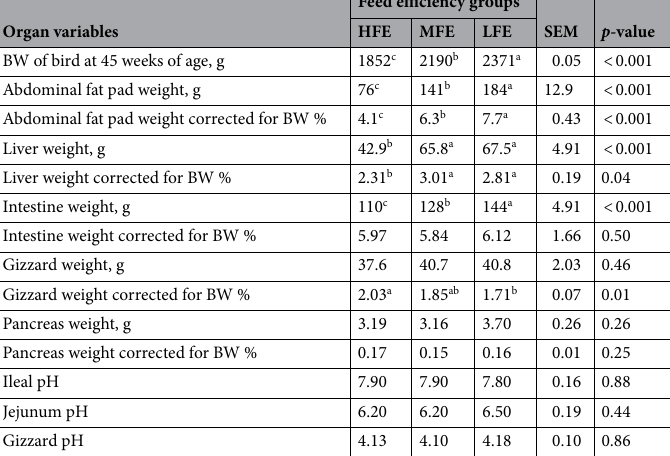
Table 1. Organ characteristics of individually housed ISA Brown hens aged 45 weeks old and ranked based of differences in feed efficiency as HFE, MFE and LFE. (n = 30; 10 per FE group). BW, body weight; HFE, high feed efficiency; MFE, medium feed efficiency; LFE: Low feed efficiency; SEM, standard error of mean; abc — means within rows not sharing a common suffix are significantly different at the 5% level of